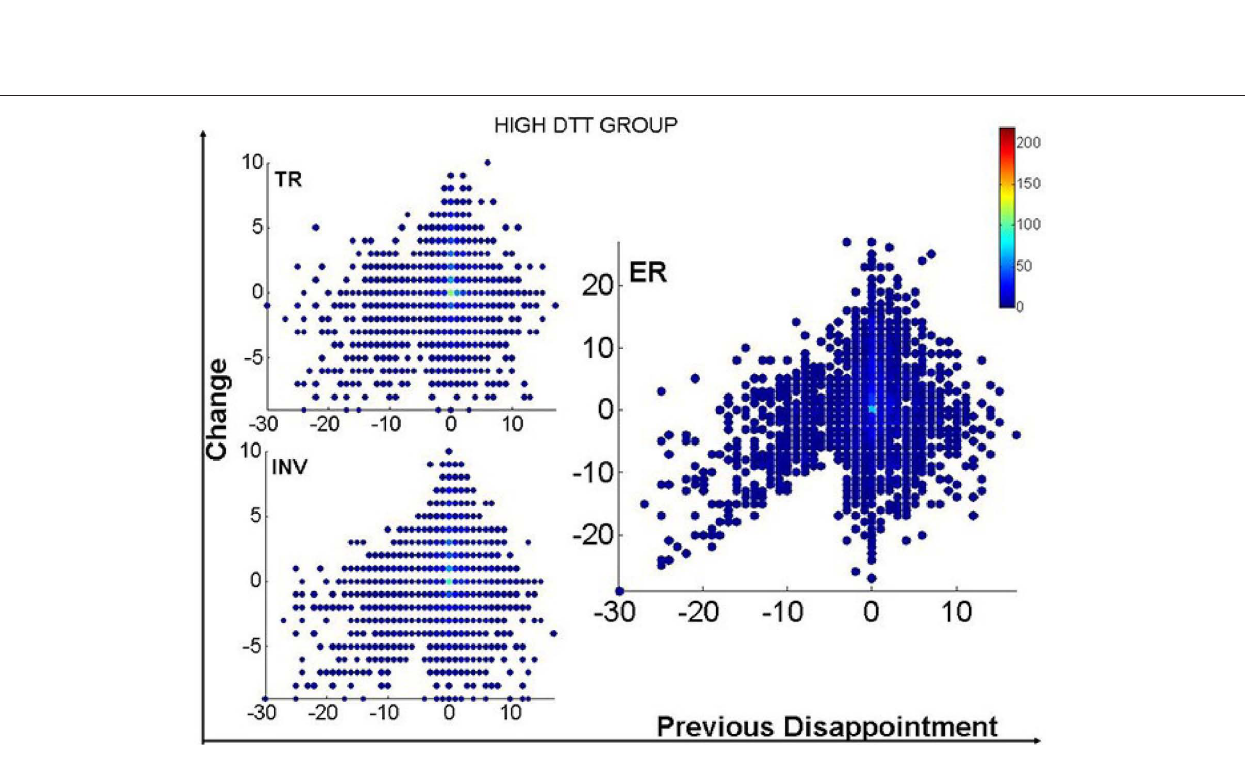
FiGurE A4 | Changes in Strategy as a function of previous disappointment. Change in the three variables under study as a function of the disappointment experienced in previous trial. TR stands for Trustworthiness Ratings, INV for the investment, and ER for the expected return (expectations). Here there is no tendency to increase any of the variables after elation. This demonstrates a weaker influence of previous history for this